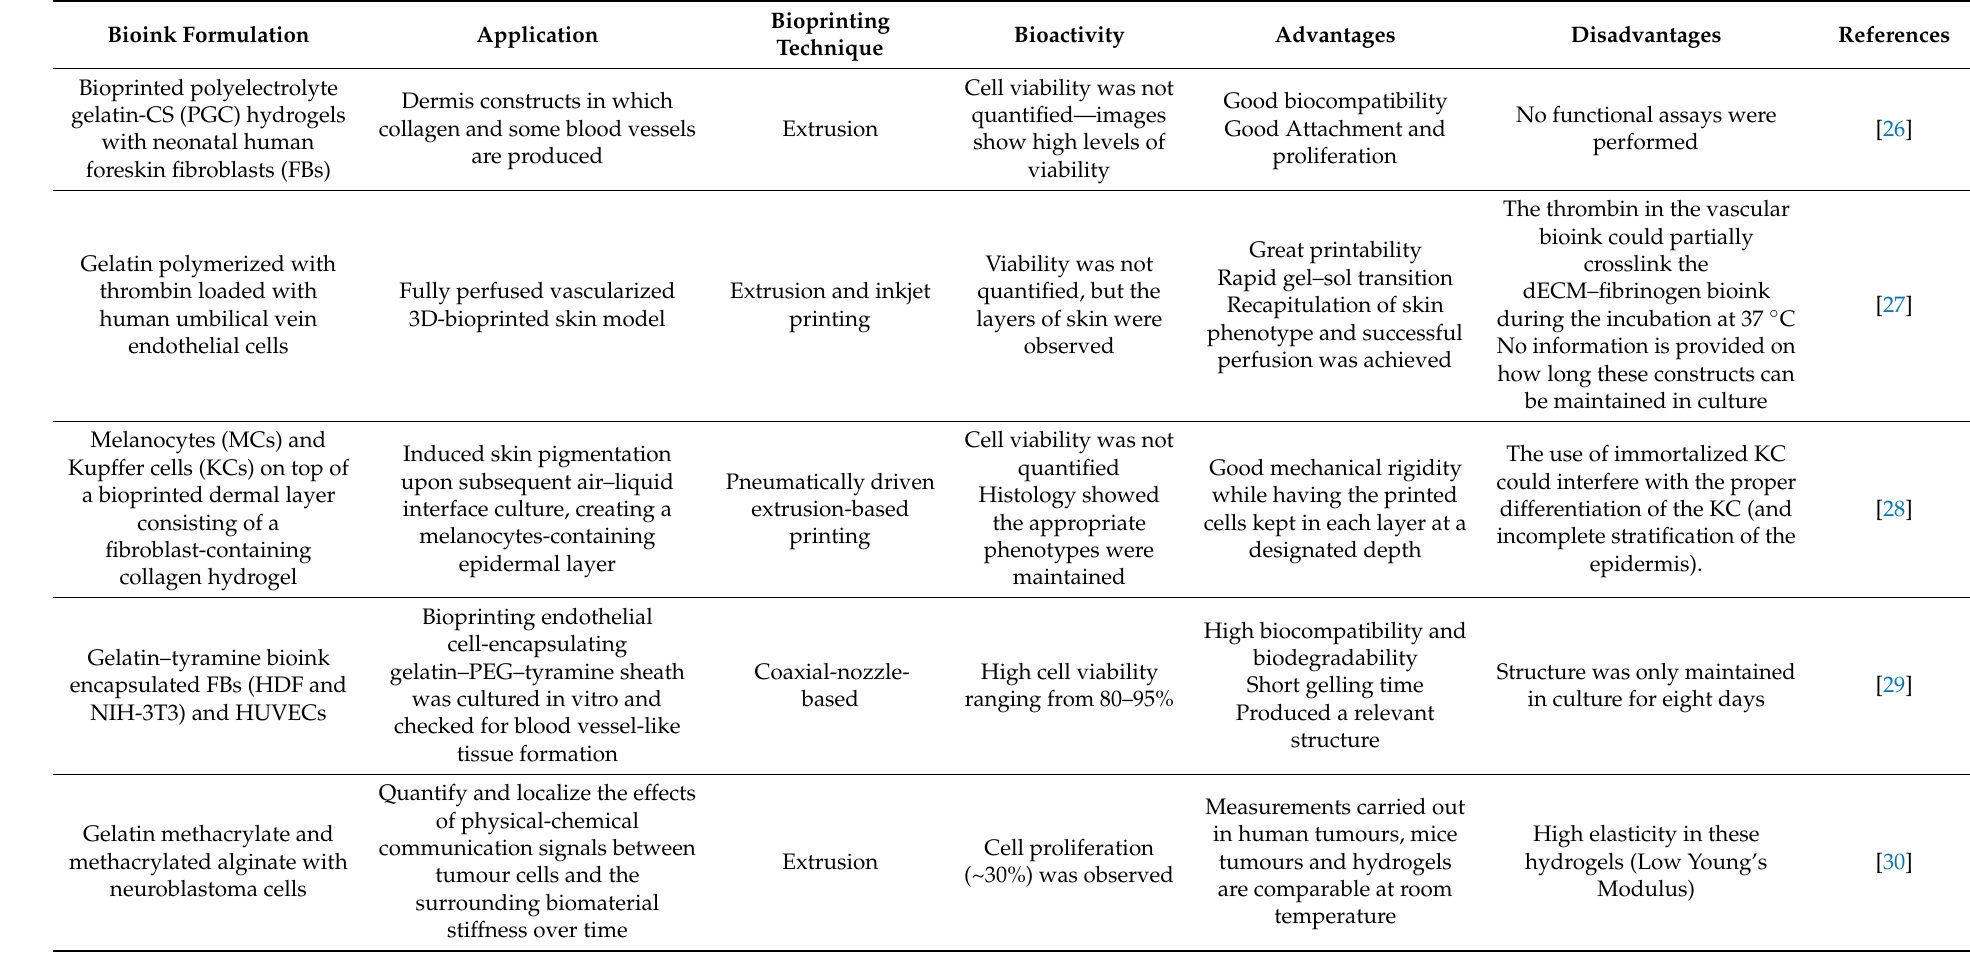
Table 1. Examples in literature of commonly used functionalized bioinks for tissue engineering